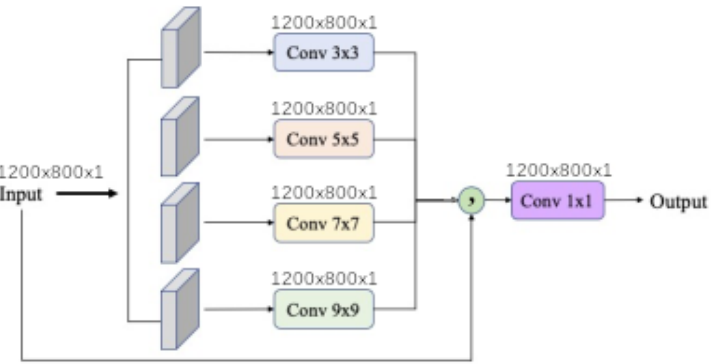
Figure 9. Spatial refinement block inserted at the end of a